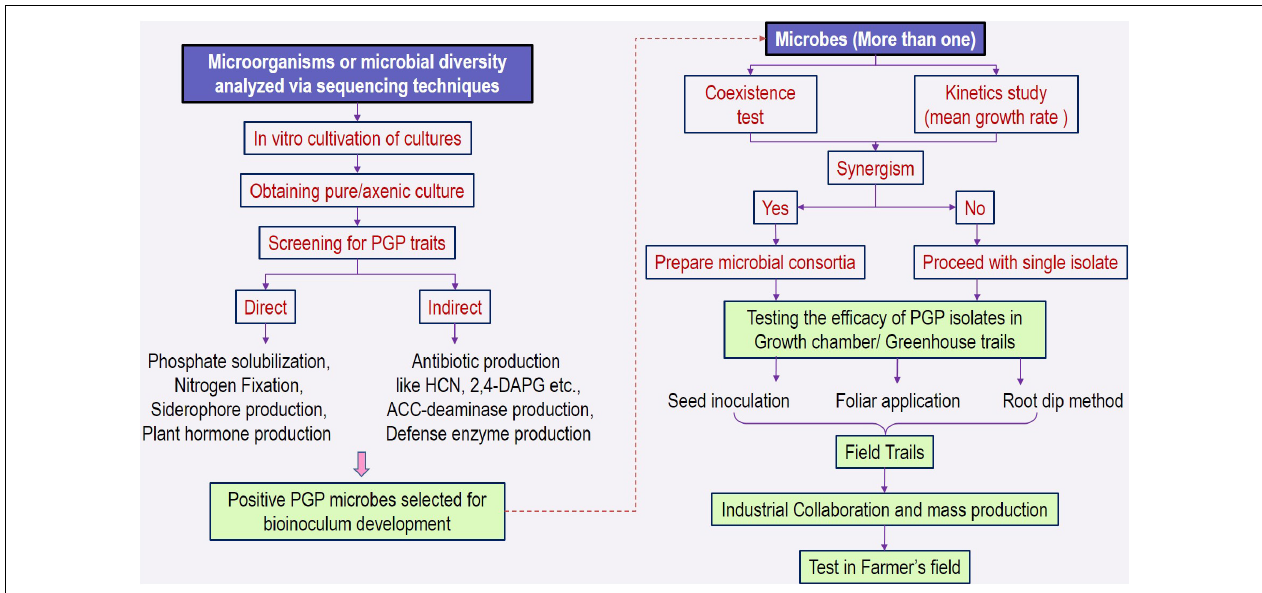
FIGURE 5 | Description of the process involved in screening microbial cultures for PGP traits and development of inoculant. PGP, plant growth–promoting traits; HCN, hydrogen cyanide; 2,4-DAPG,